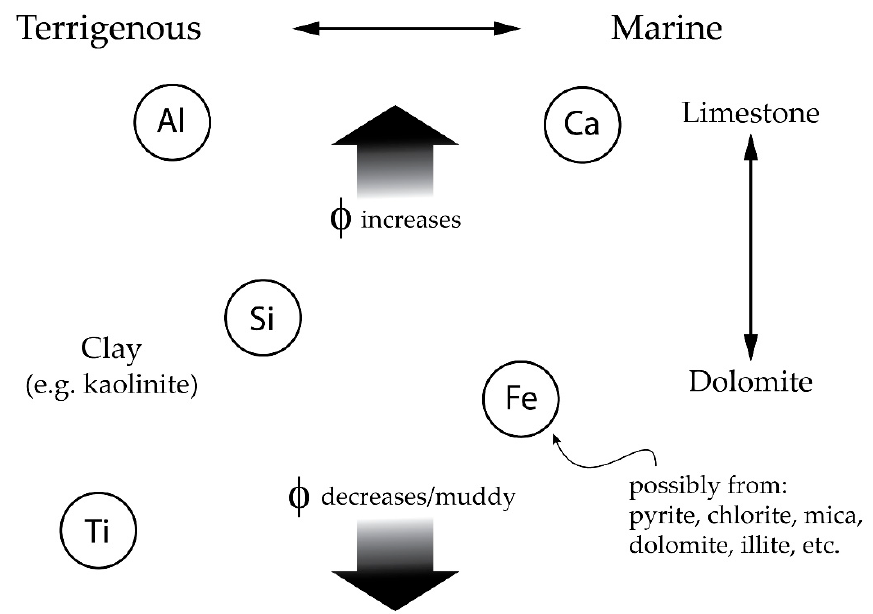
Figure 7. The five elements (aluminum, calcium, iron, silicon, and titanium) with most significance (p-value < 0.05) from the multiple regression and their relation to the depositional environment. Porosity increases from the bottom to top of the figure.